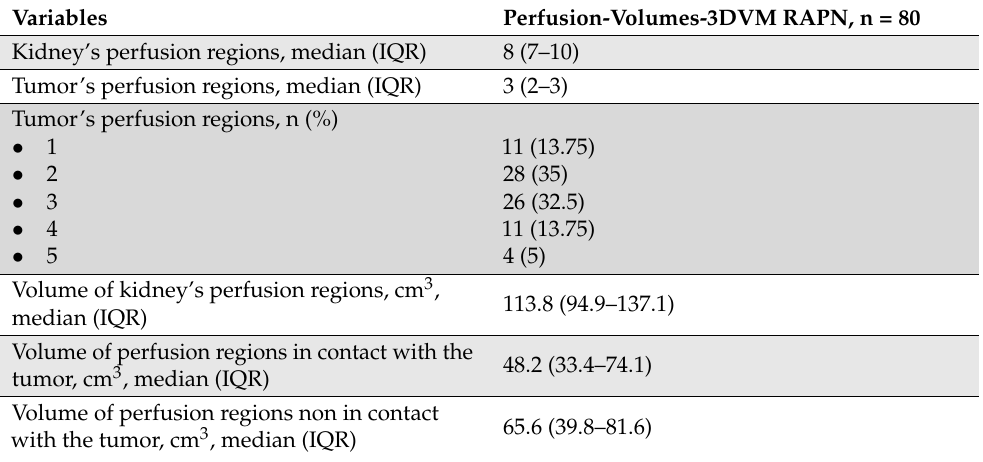
Table 3. Perfusional kidney and tumor